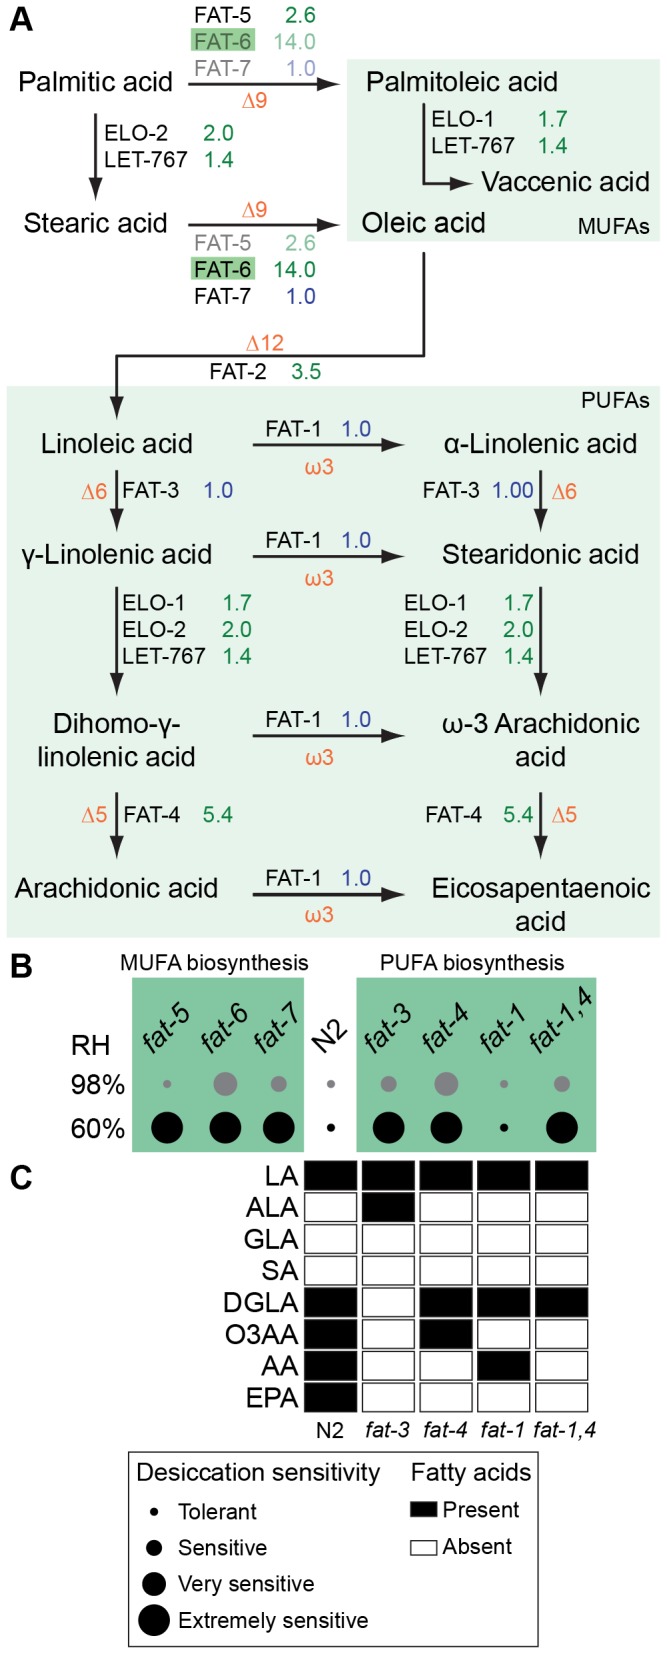
Arachidonic acid is essential for desiccation tolerance.(A) The major components in the biosynthesis of MUFAs and PUFAs in C. elegans (highlighted according to Figure 1). Type of desaturation is shown in orange for every reaction. Modified from [57,59]. (B) Desiccation sensitivities of FAT mutants in 4 categories. (C) PUFA profiles of preconditioned dauer larvae of wild-type worms and fat mutants. Filled and empty boxes indicate the presence and absence of the PUFA species, respectively. LA, Linoleic acid; ALA, α-linolenic acid; GLA, γ-linolenic acid; SA, stearidonic acid; DGLA, dihomo-γ-linolenic acid; O3AA, ω-3 arachidonic acid; AA, ω-6 arachidonic acid; EPA, eicosapentaenoic acid.